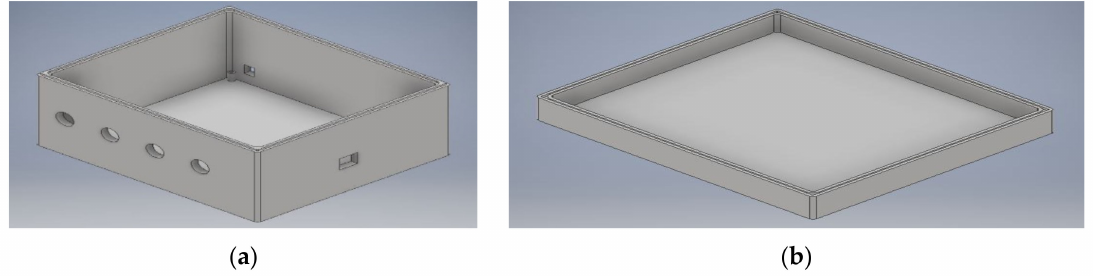
Figure 3. A 3D view of the board dedicated box: ( a ) base of the box; ( b ) box